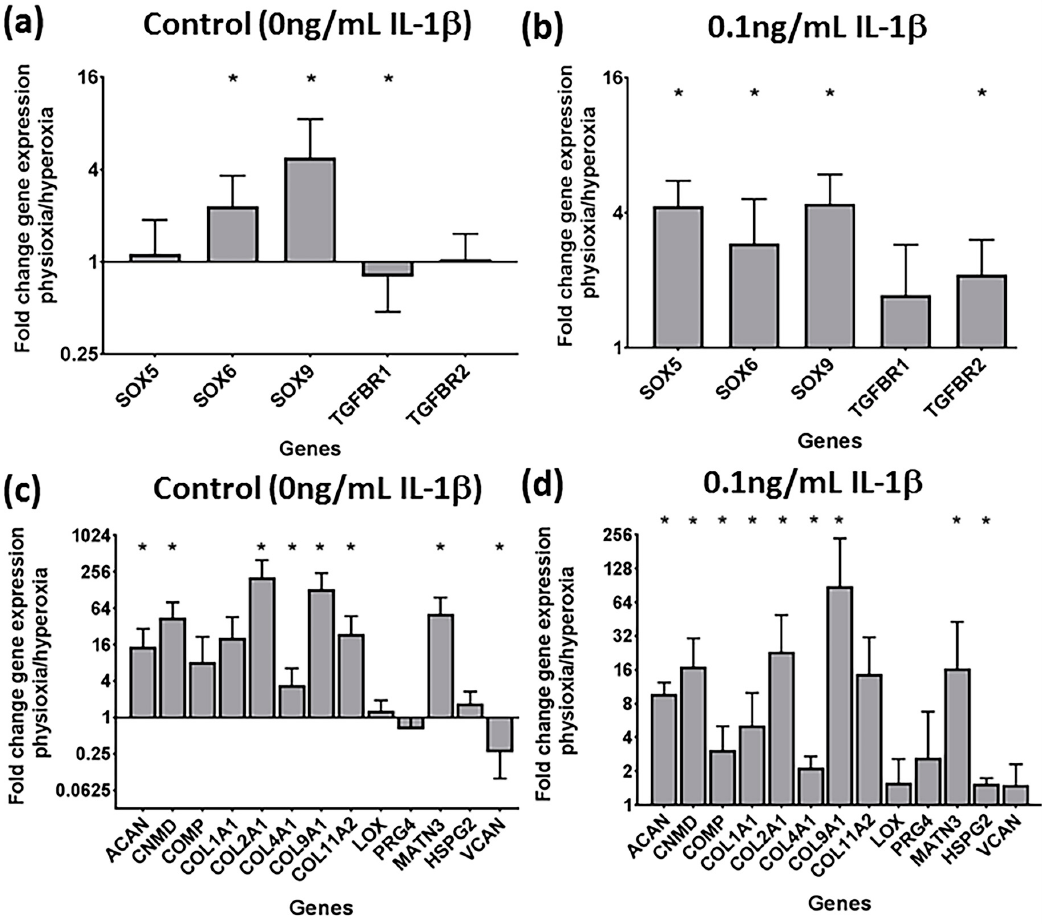
Figure 5. Gene expression of ( a , b ) chondrogenic transcription factors and ( c , d ) cartilage matrix proteins under physioxia for ( a , c ) control and in the presence of ( b , d ) 0.1 ng / mL IL-1 β for physioxia responsive donors. Data represents the fold change in expression of pellets cultured under ( a , c ) 0 ng / mL and ( b , d ) 0.1 ng / mL IL-1 β physioxia relative to the corresponding conditions under hyperoxia. Data represent mean ± S.D. of n = 4 physioxia responsive donors; * p <